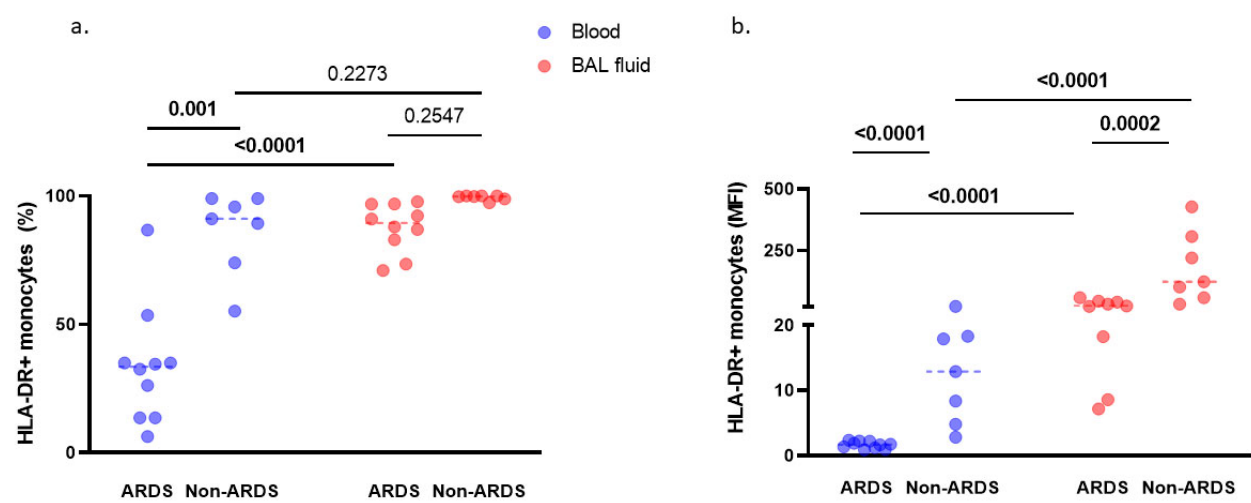
Figure 2. HLA-DR expression on monocytes in broncho-alveolar lavage (BAL) fluid and blood of pneumonia-related ARDS